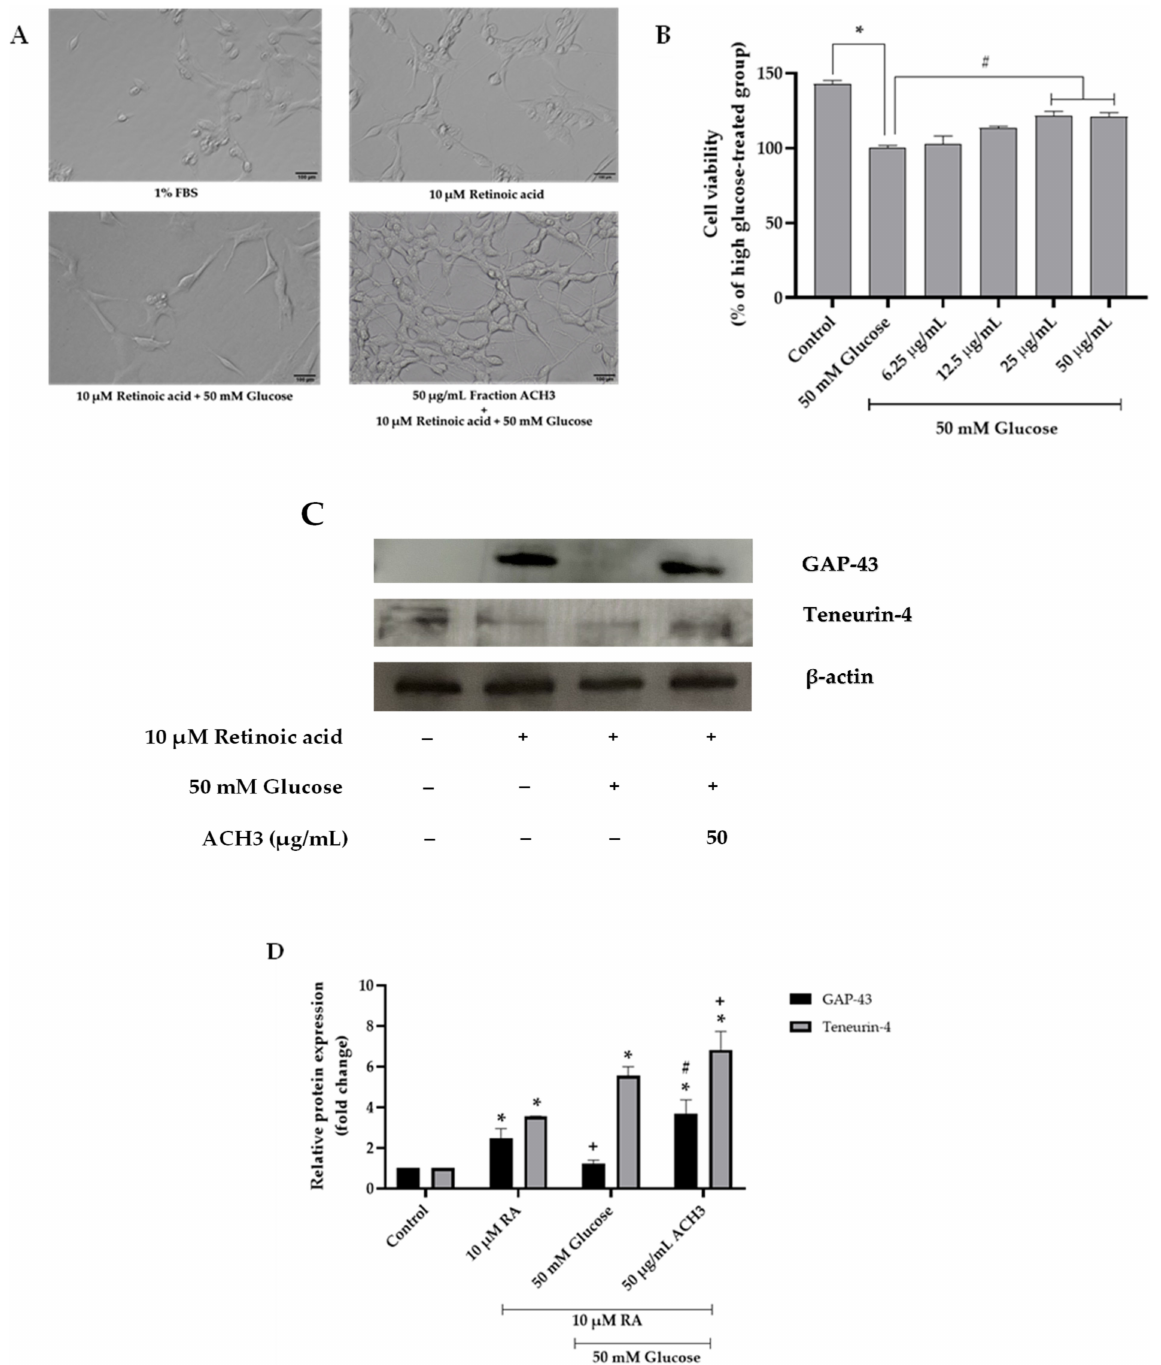
Figure 8. The effect of fraction ACH3 on neurite outgrowth ( A ). MTT assay was performed to clarify the effect of fraction ACH3 on cell viability ( B ). GAP-43 and Teneurin4 expression shown in a representative Western blot ( C ). Normalized values of both GAP-43 and Teneurin-4 against β -actin ( D ). All data are presented as the mean ± SEM, * p < 0.05 vs. control; + p < 0.05 vs. 10 µ M RA; # p < 0.05 vs. high glucose-treated